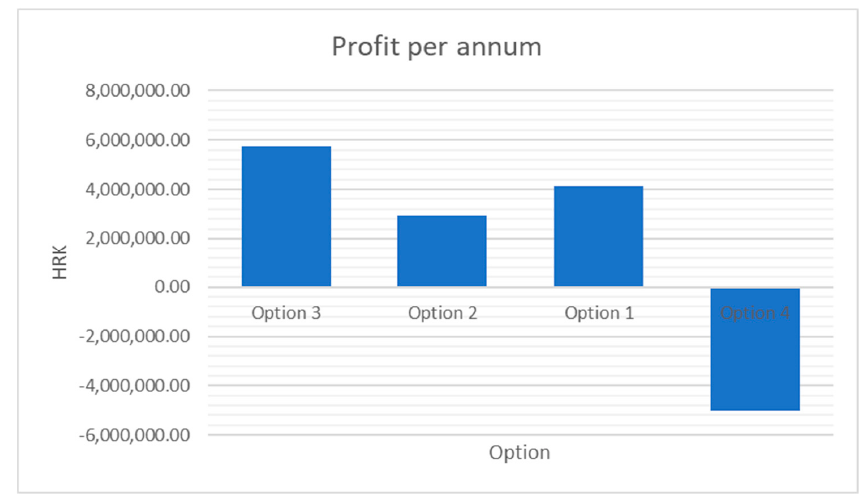
Figure 3. Profit of each facility per annum with incentive prices